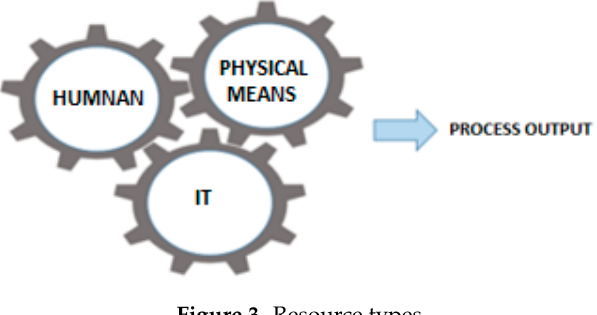
Figure 3. Resource Figure 3. Resource types.